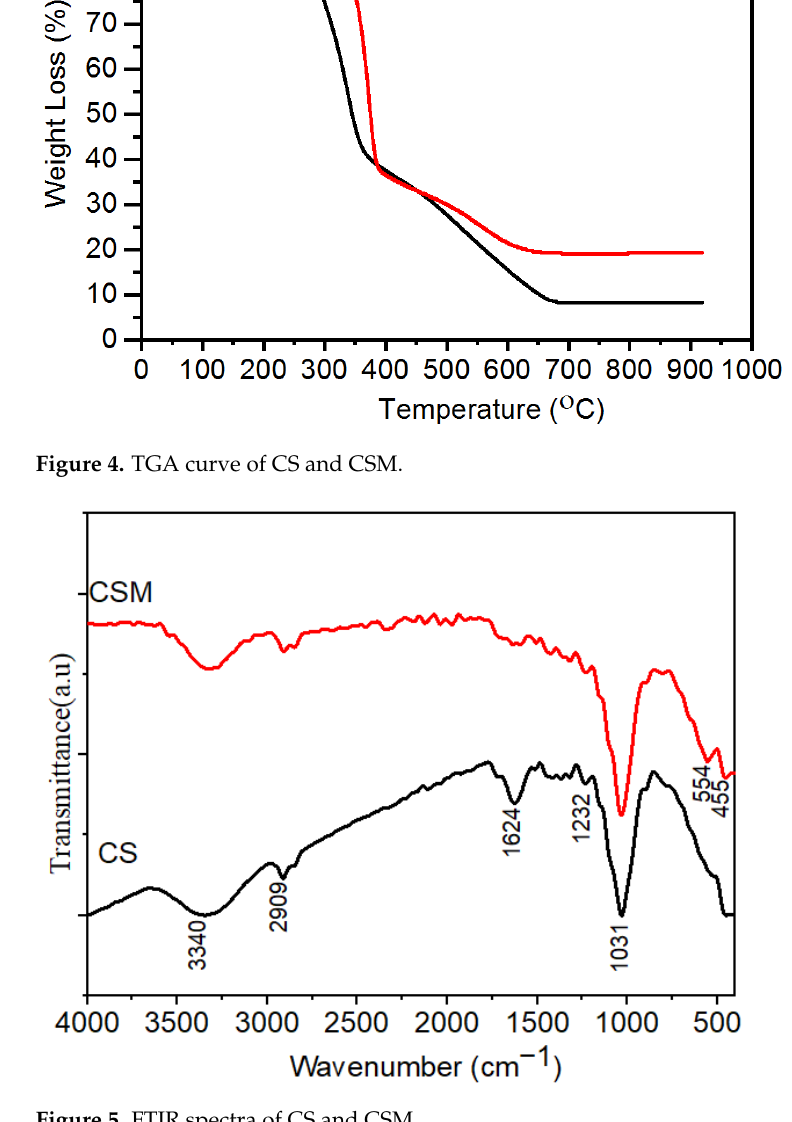
Figure 5. FTIR spectra of CS and CSM.